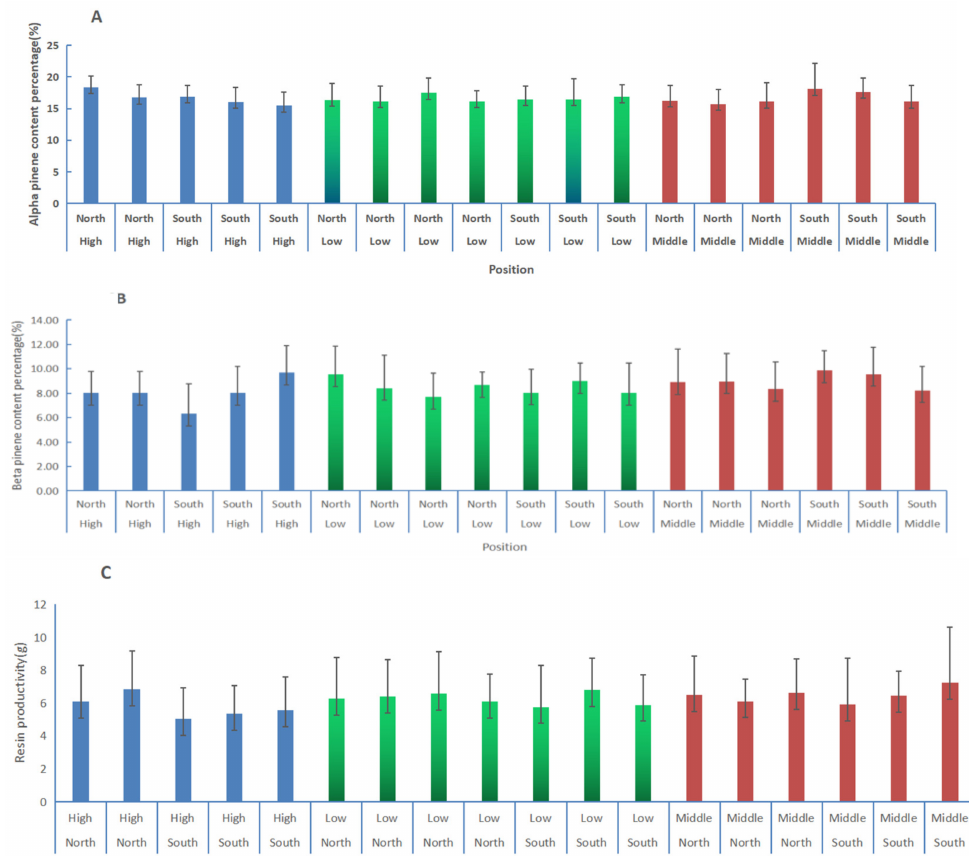
Figure 4. The α -Pinene ( A ) and β -pinene ( B ) contents and resin productivity ( C ) of the trees in each